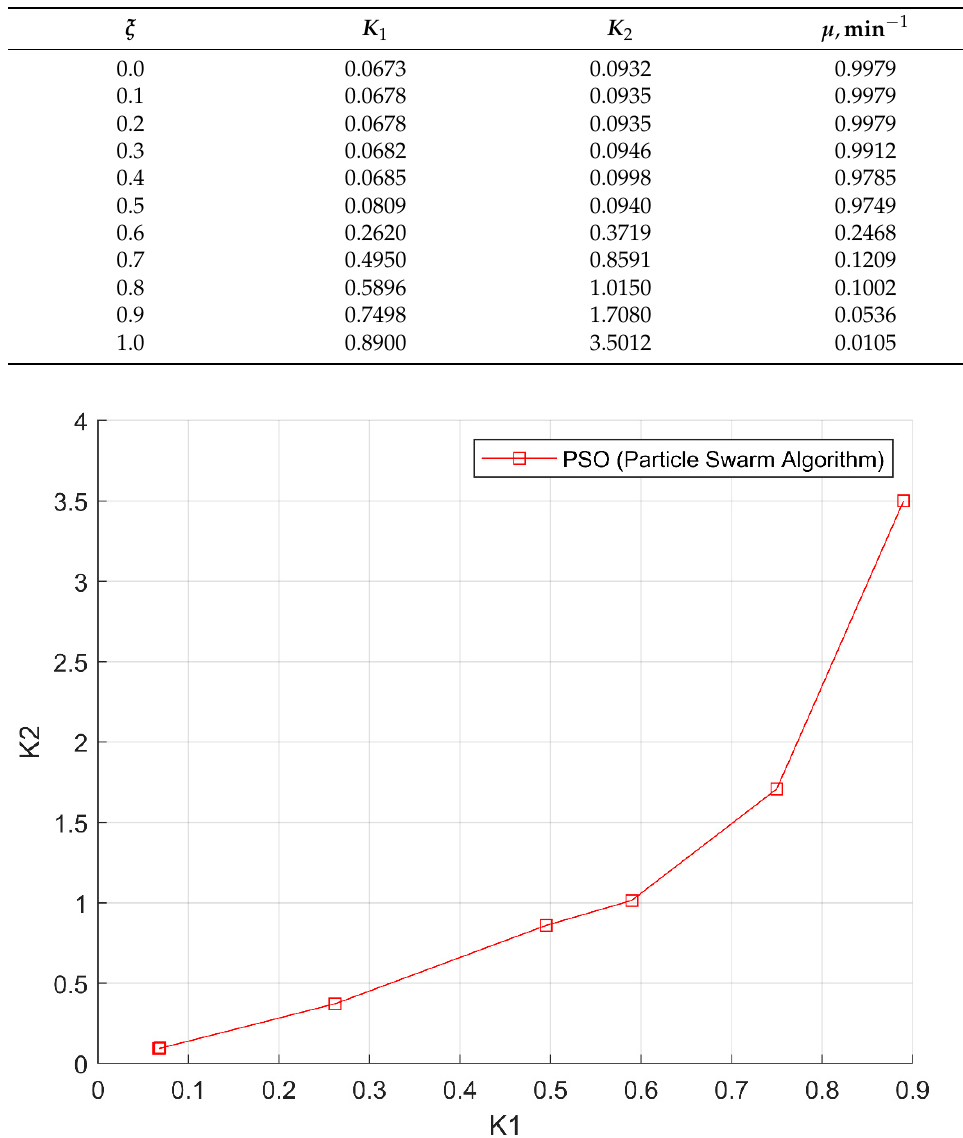
Table 2. Optimization results by the method using a particle swarm algorithm.